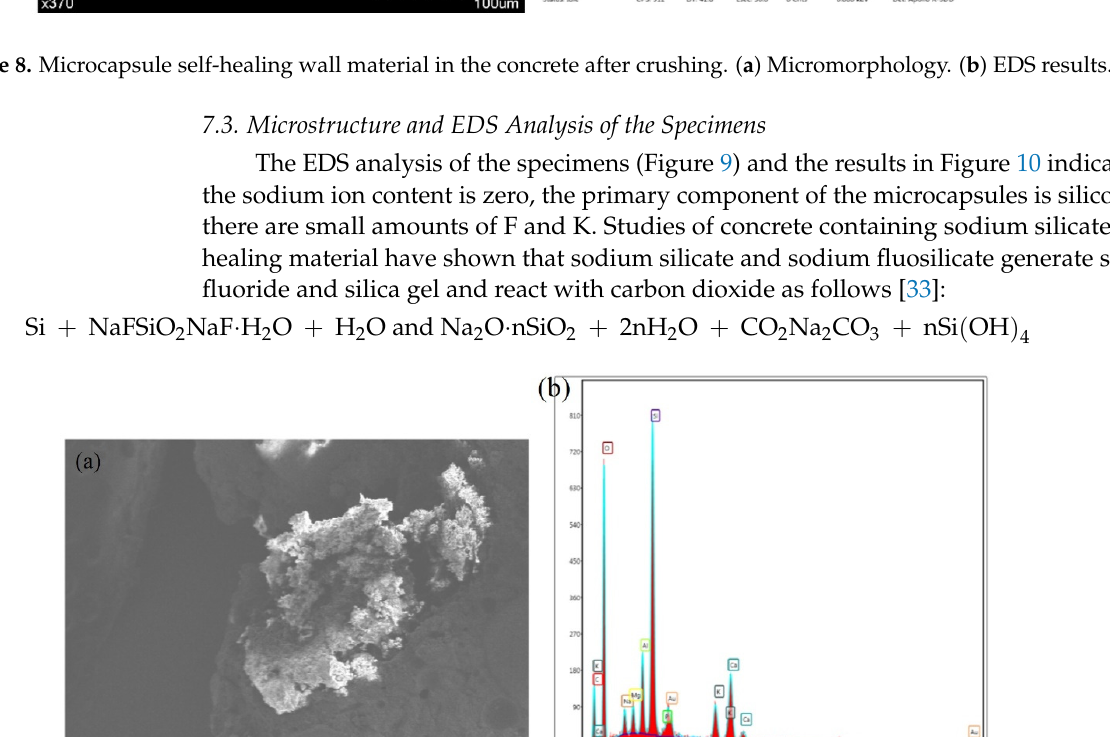
Figure 8. Microcapsule self-healing wall material in the concrete after crushing. ( a ) Micromorphology. ( b ) EDS results.